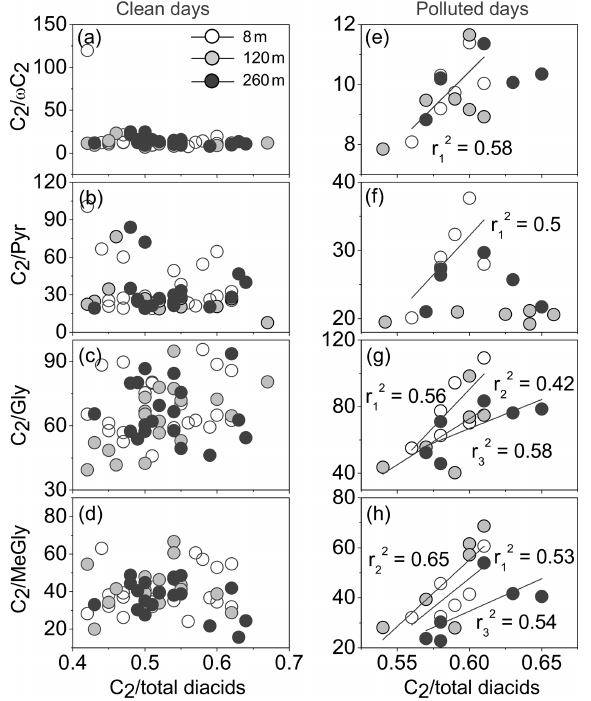
Figure 8. Correlations between concentration ratios of C 2 /ω C 2 , C 2 / Pyr, C 2 / Gly, C 2 / MeGly and C 2 / total diacids on clean days and during polluted episodes. The r 2 correlation coefficients at 8, 120 and 260m, respectively.